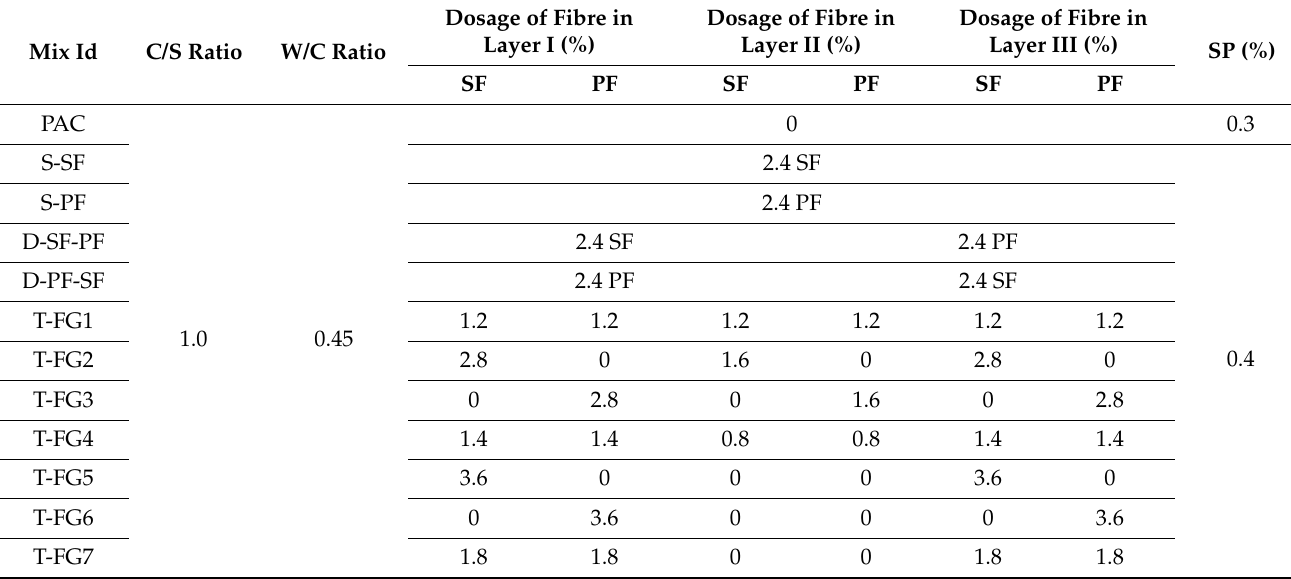
Table 1. Mixing details of developed